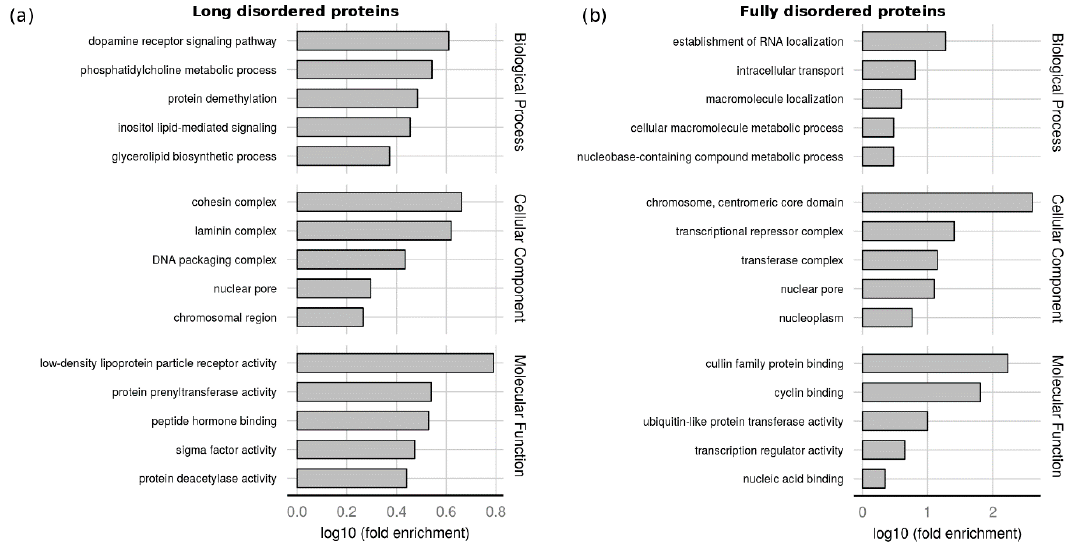
Figure 5. GO-terms enrichment analysis. Five most enriched GO-terms in the three ontologies for ( a ) long disordered proteins and ( b ) Fully disordered proteins. The background set was all UniProt sequences with at least one PDB structure. The x-axis shows the logarithmic increase compared to the background (see Methods for details).